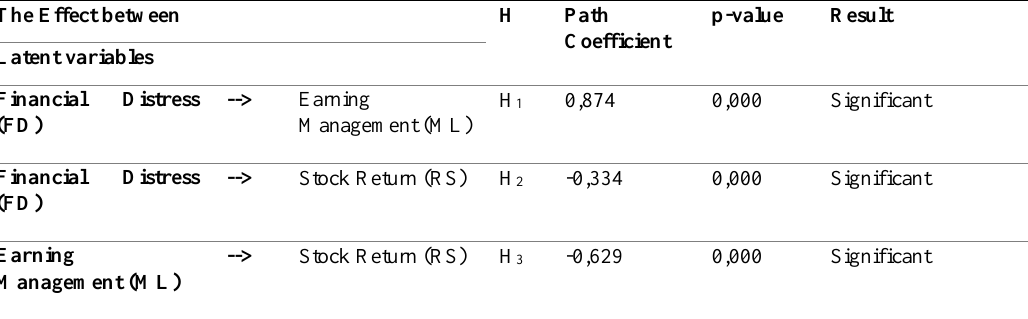
Table 1: Hypothesis Test Results Model 1